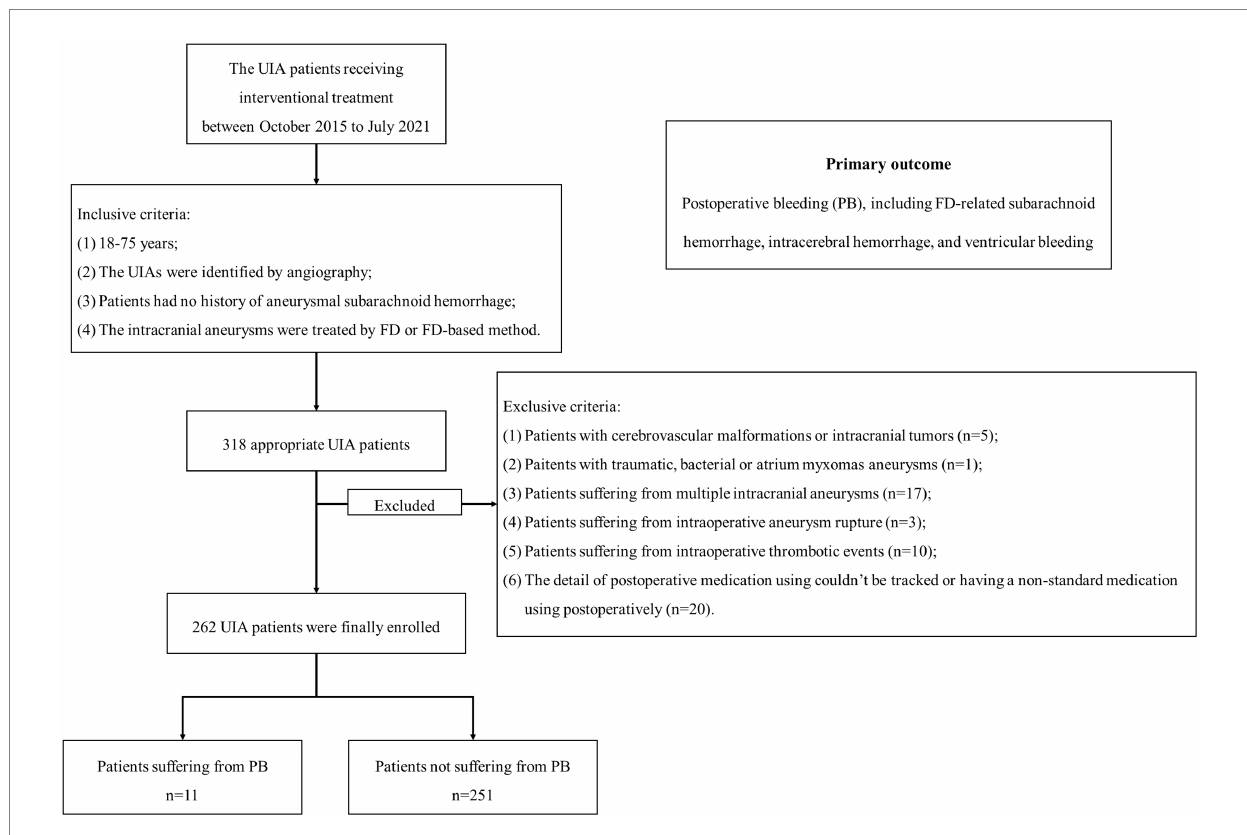
FIGURE 1 The flow chart of patient enrollment. We included 262 patients with 262 UIAs in this study. Among them, 11 patients suffered from PB. UIA, unruptured intracranial aneurysm; PB, postoperative